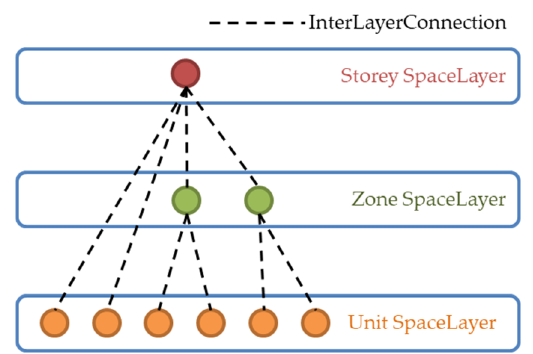
Figure 8. InterLayerConnection between SpaceLayers representing each hierarchical level.